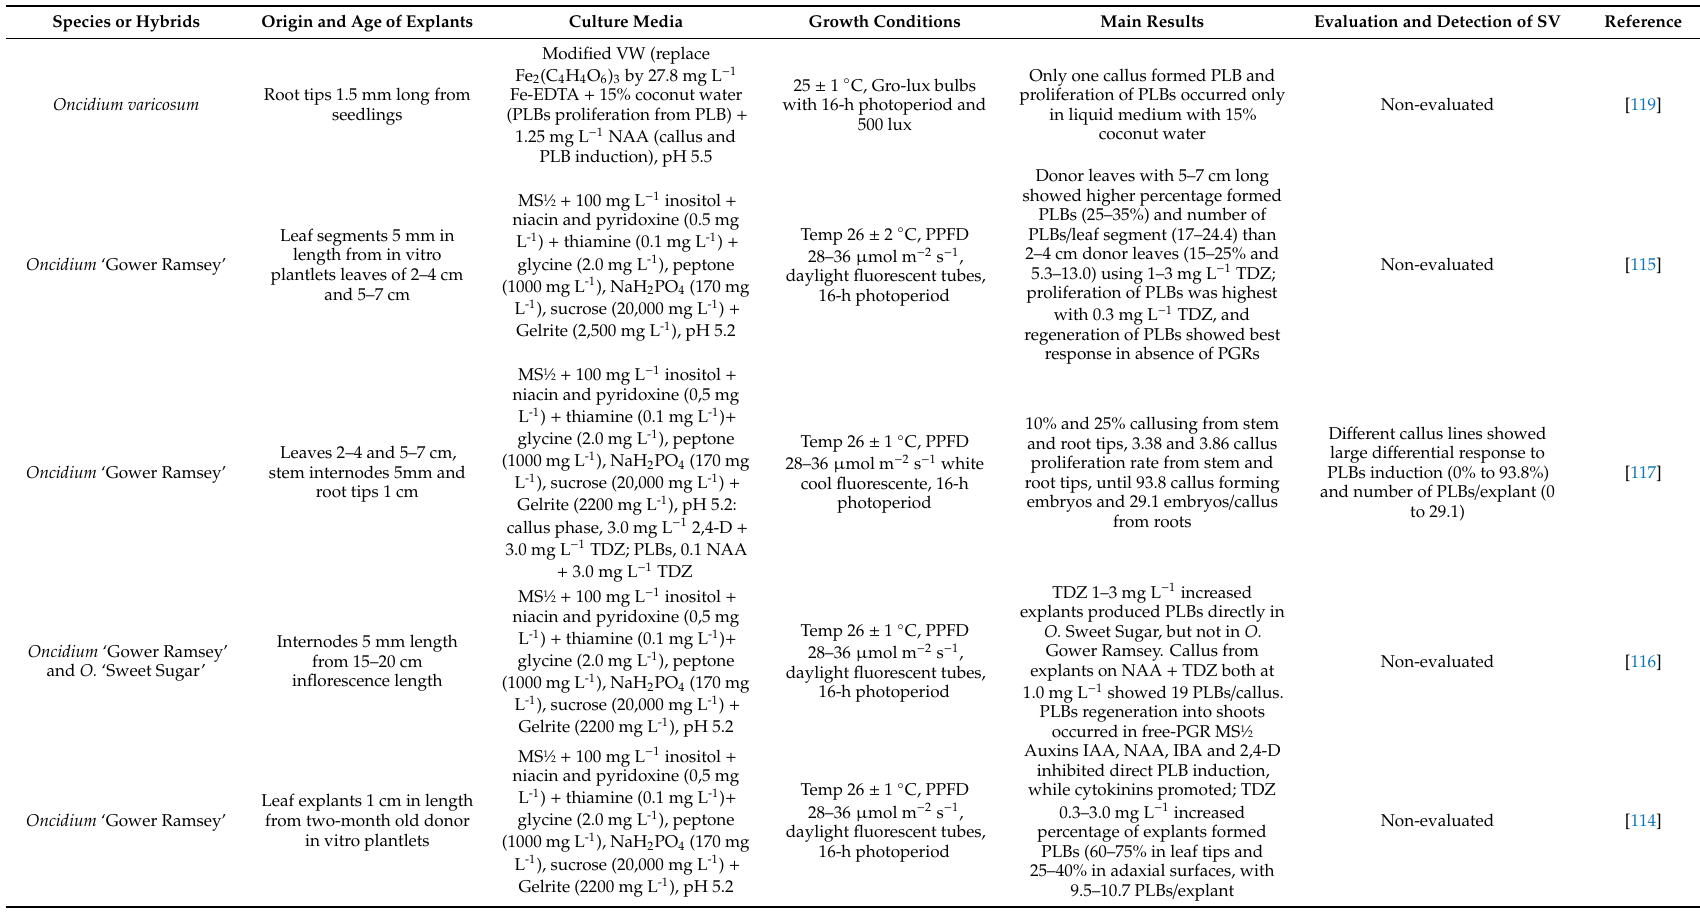
Table 2. Compliance of studies with induction, proliferation and regeneration of PLBs (IPR-PLBs) technique used with Oncidium species and